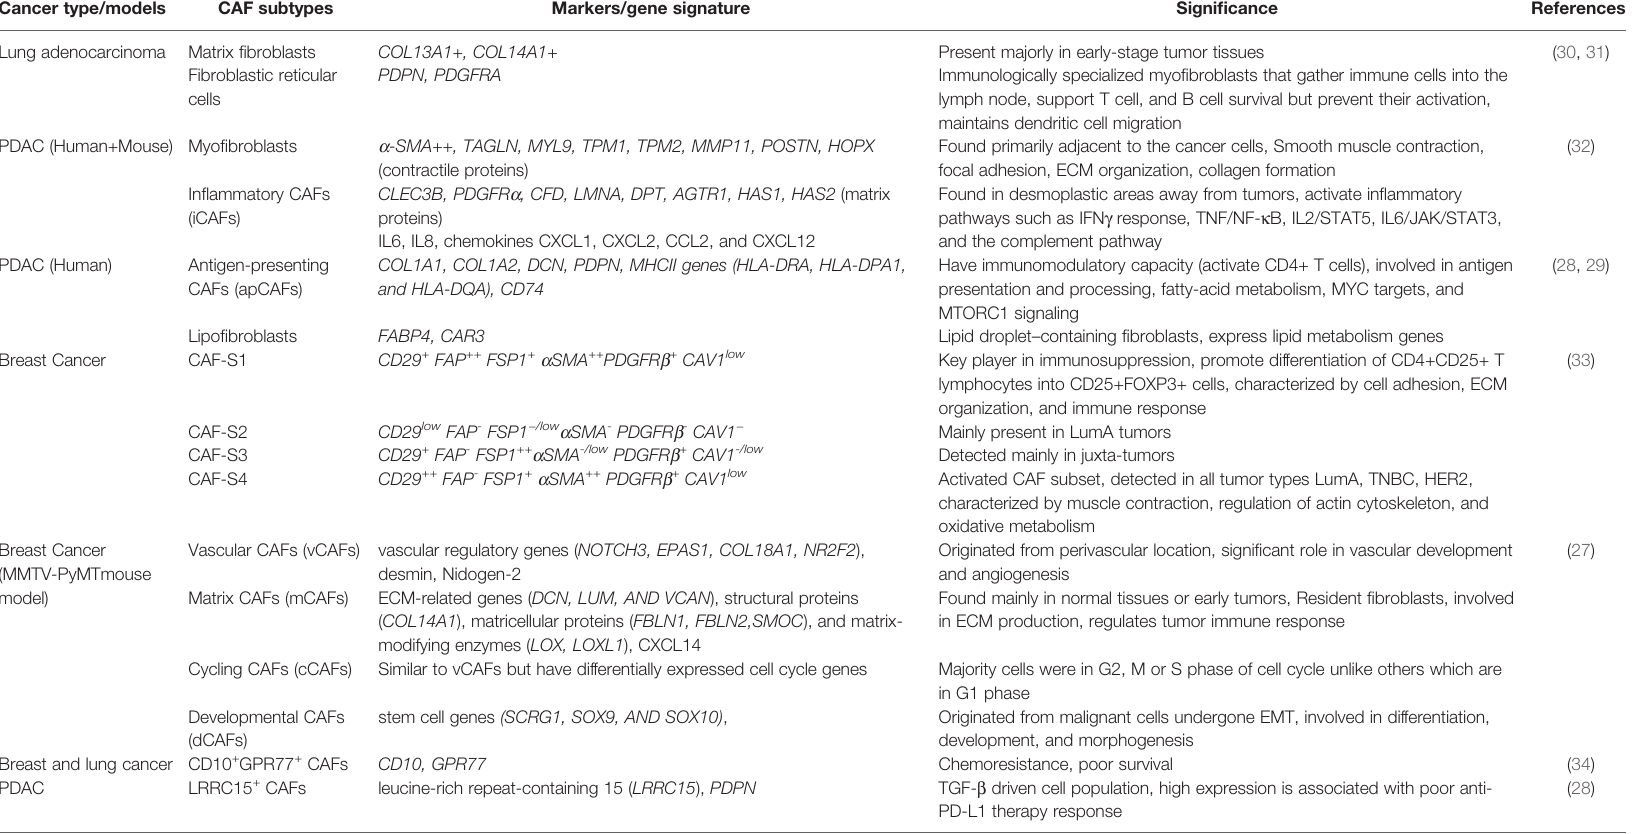
TABLE 1 | Cancer-associated fi broblast subtypes found in tumor tissues as revealed by single cell RNA sequencing. Cancer